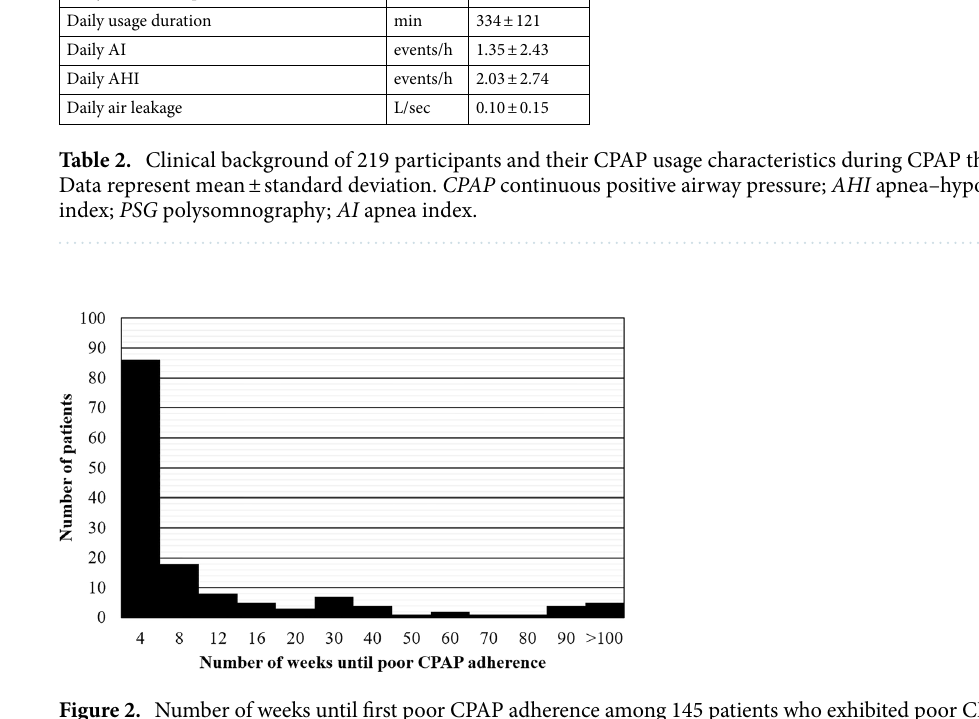
Figure 2. Number of weeks until first poor CPAP adherence among 145 patients who exhibited poor CPAP